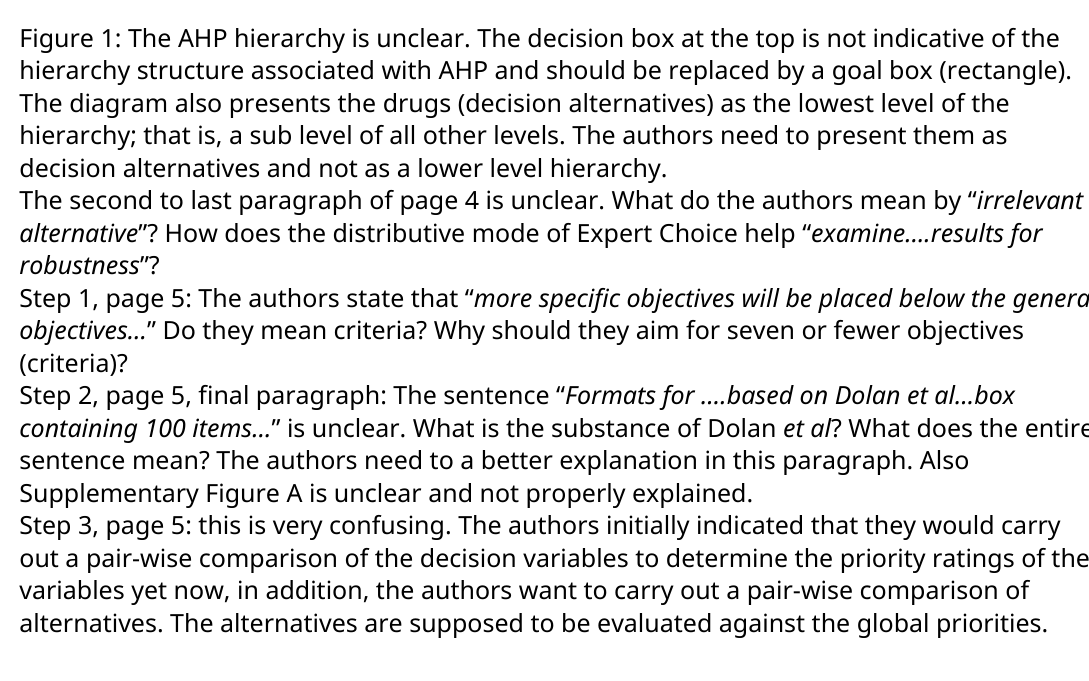
Figure 1: The AHP hierarchy is unclear. The decision box at the top is not indicative of the hierarchy structure associated with AHP and should be replaced by a goal box (rectangle). The diagram also presents the drugs (decision alternatives) as the lowest level of the hierarchy; that is, a sub level of all other levels. The authors need to present them as decision alternatives and not as a lower level